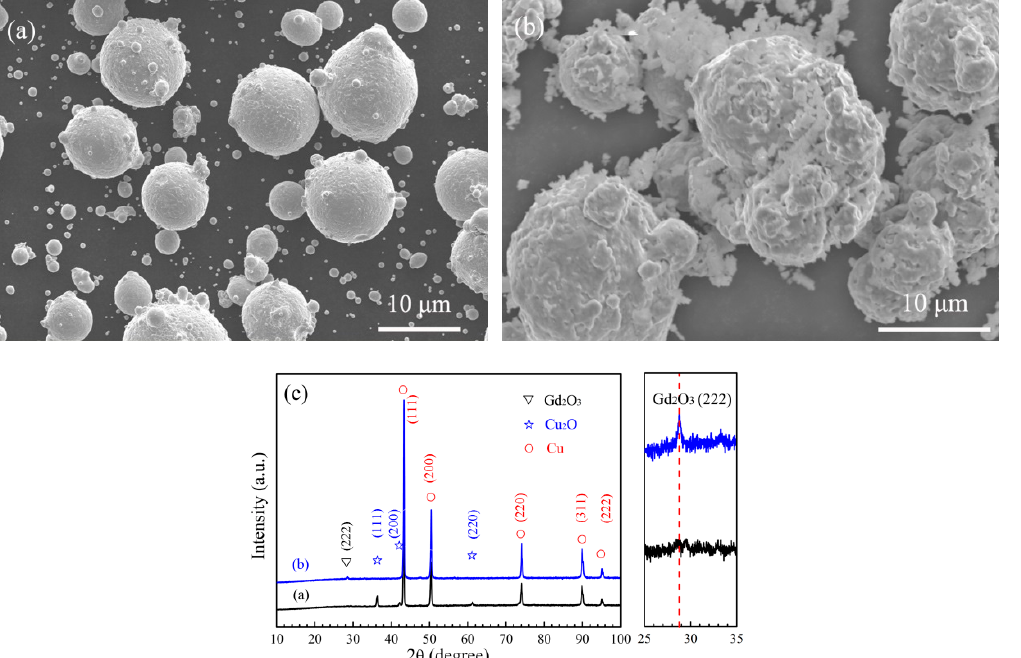
Figure 4. The powder analysis of in situ synthesis of Gd 2 O 3 : ( a , b ) the morphology of Cu-Gd alloy powder mixed with Cu 2 O powder before internal oxidation and after H 2 reduction; ( c ) the XRD patterns of the mixed powders in Figure 4a,b.